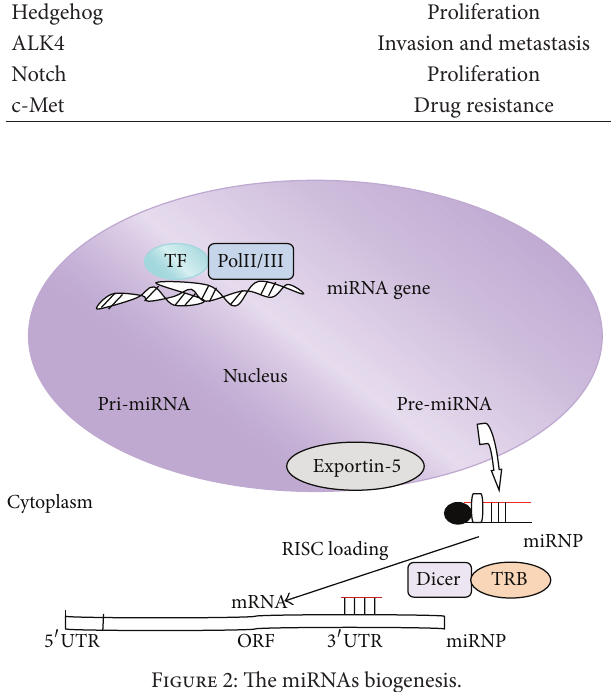
Figure 2: The miRNAs